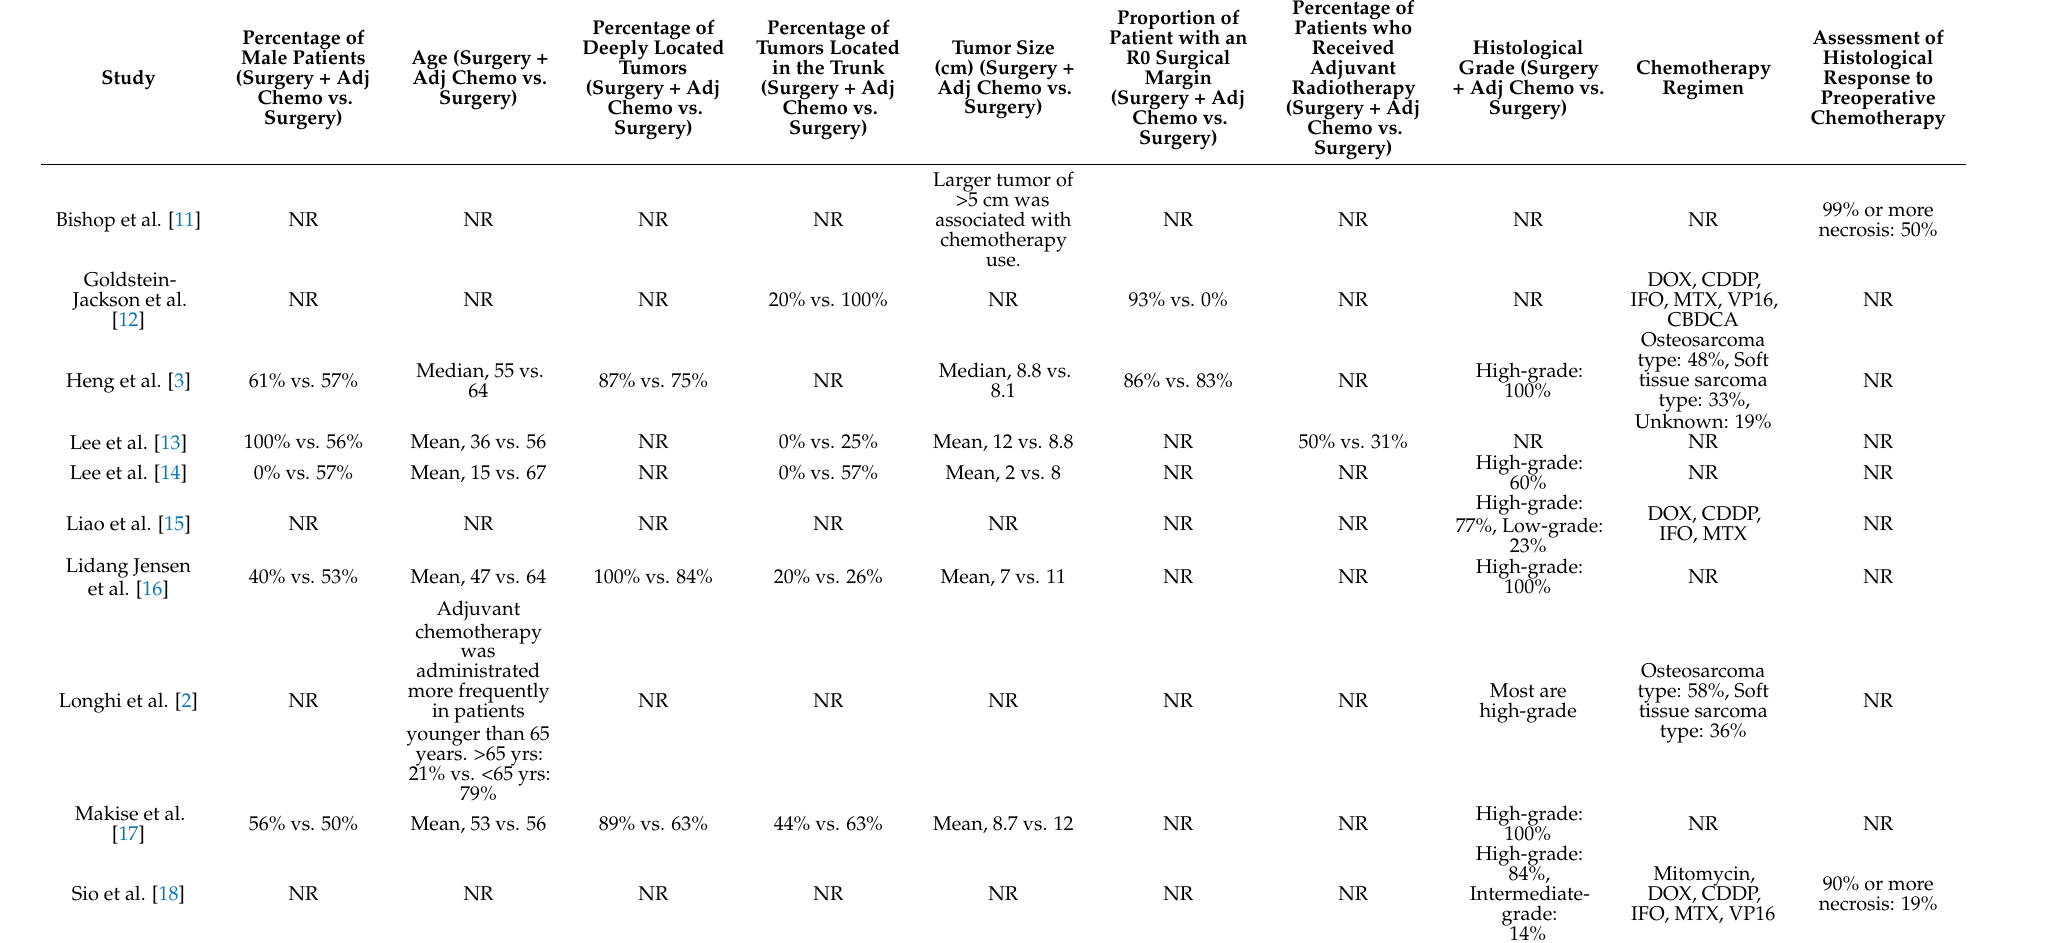
Table 2. Details of the patients included in this